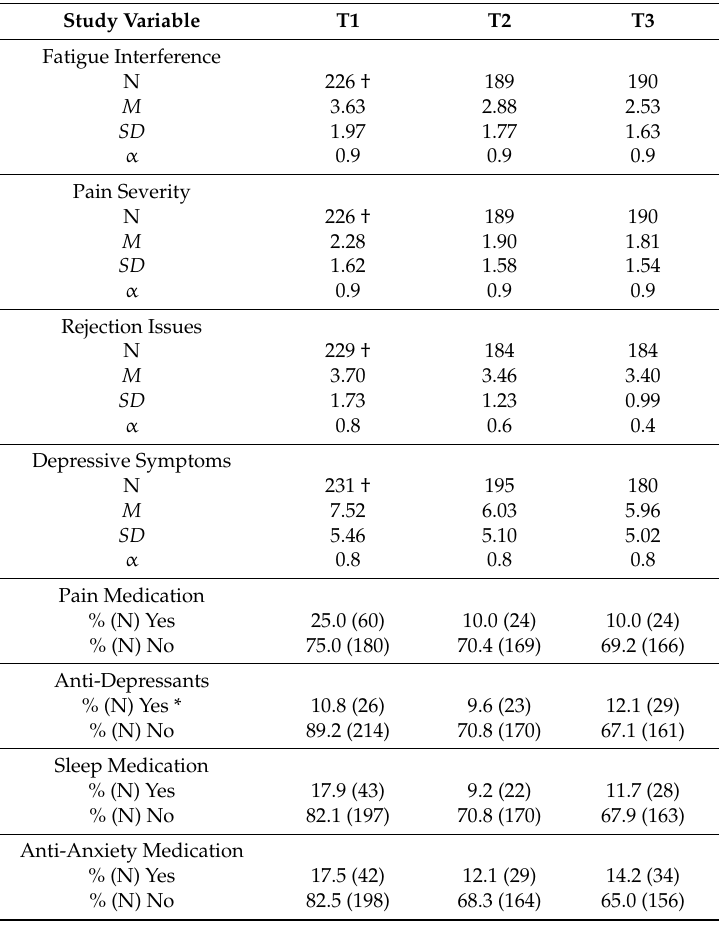
Table 2. Descriptive statistics and internal consistency of key study variables at each assessment time